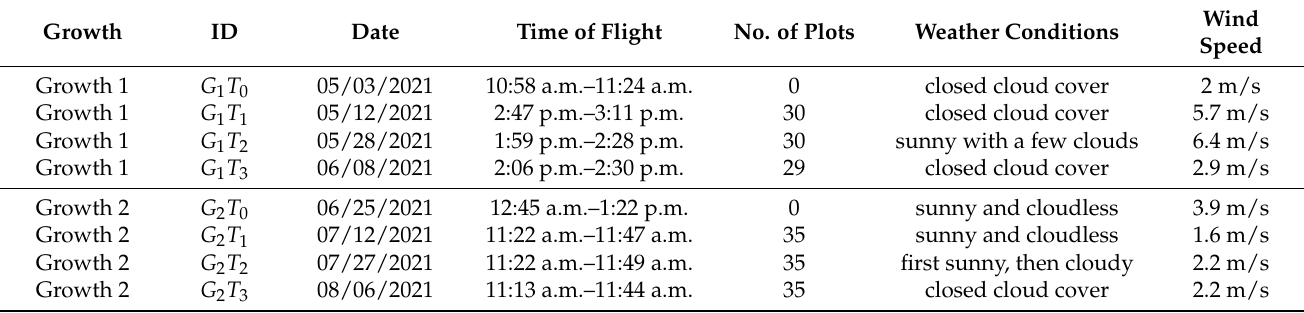
Table 1. Growth, observation dates and times, number of botanically observed plots, weather conditions, and wind speed during the